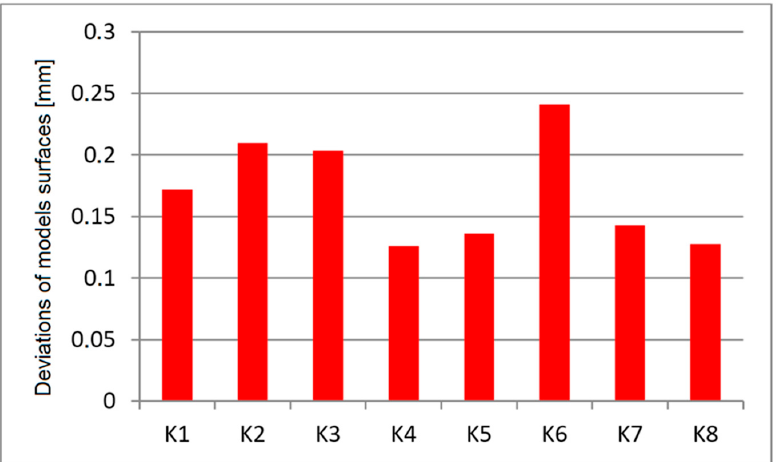
Figure 16. Value of the surface average deviation of the scanned model after tests in relation to the model before tests.